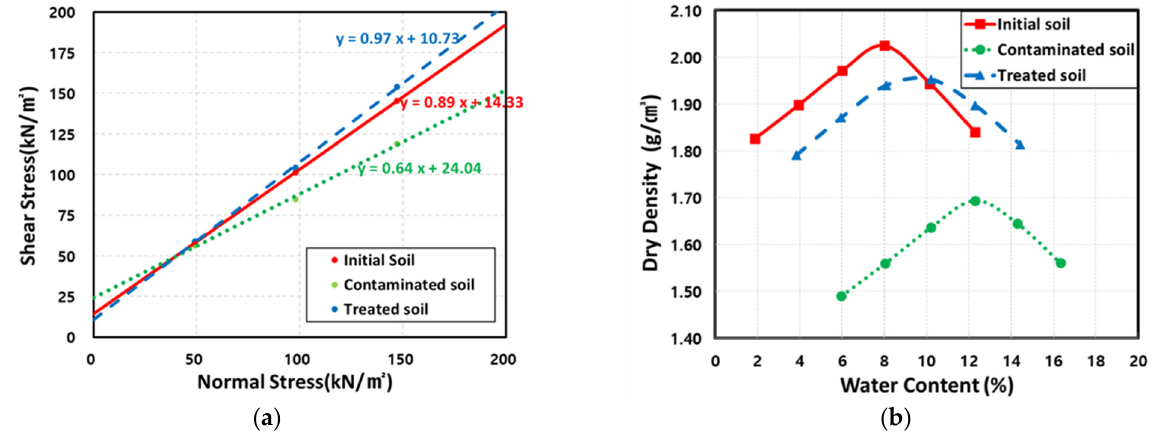
Figure 7. Results of the ( a ) Direct shear test and ( b ) Compaction test.